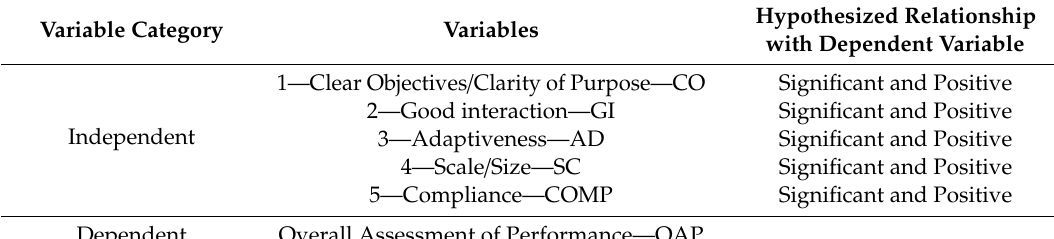
Table 1. Hypothetical relationship between overall assessment of performance and di ff erent institutional variables.